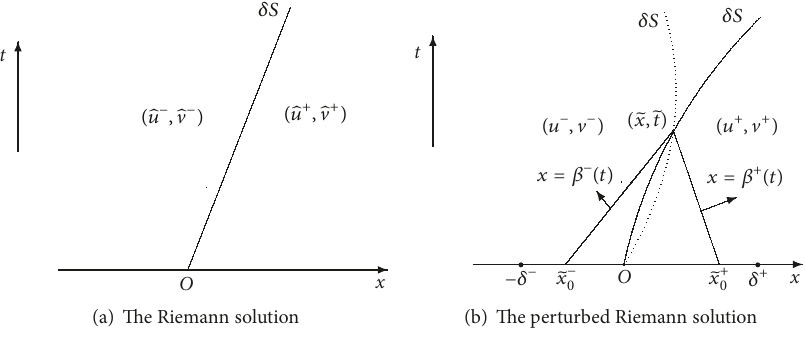
Figure 2: Case 1, Case 2 with ̇𝑢 − 0 (0) < 0 , and Case 3 with ̇𝑢 + 0 (0) < 0